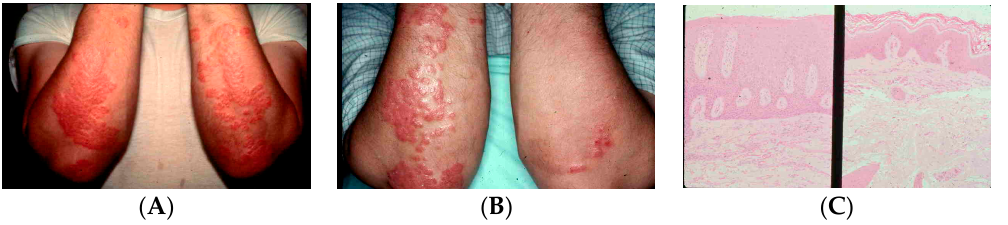
Figure 12. A young man with chronic psoriasis with no effective treatment. He was a participant in our clinical research trial evaluating the effectiveness of topical-applied 1,25-dihydroxyvitamin D3 that I formulated in Vaseline with a concentration of 50 mcg/gram. This was a double-blind placebo-controlled trial with one side receiving topical Vaseline and the other side receiving topical Vaseline containing 1,25-dihydroxyvitamin D3. ( B ) After 2 months, there was dramatic improvement on the right forearm that had received the active metabolite. ( C ) A skin biopsy was taken from each forearm and the histology of the skin biopsy from the right forearm shown on the right side of figure ( C ) revealed a dramatic improvement by marked decreases in the keratinocyte proliferation with induction of terminal differentiation to normalize the skin. Holick copyright 2023.